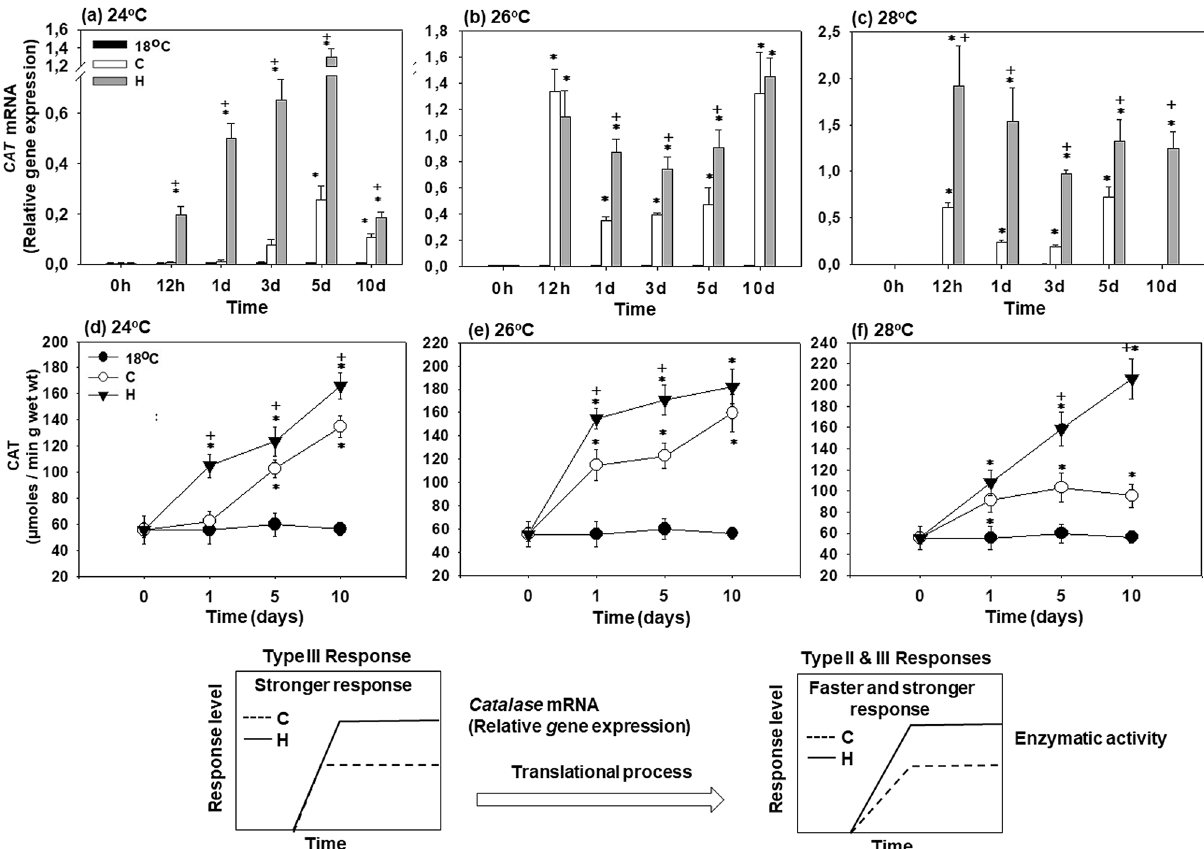
Figure 4. Changes in the relative CAT mRNA levels [Type III (stronger) response] and CAT enzymatic activity [Type II & III (faster and stronger) responses] in the mantle of heat hardened (H) and non-hardened (C) Mytilus galloprovincialis when exposed to 24 °C ( a , d ), 26 °C ( b , e ) and 28 °C ( c , f ) compared to control at 18 °C. Values are means ± SD, n = 8 preparations from different animals. * p < 0.05 compared to day 0, + p < 0.05 compared to non-hardened (C)